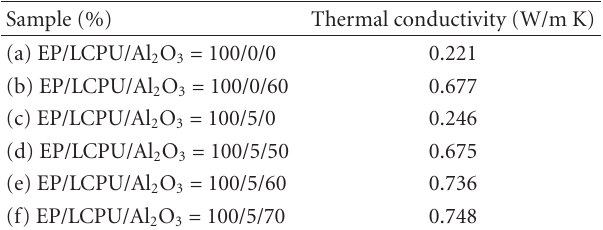
Table 2: Thermal conductivity of the